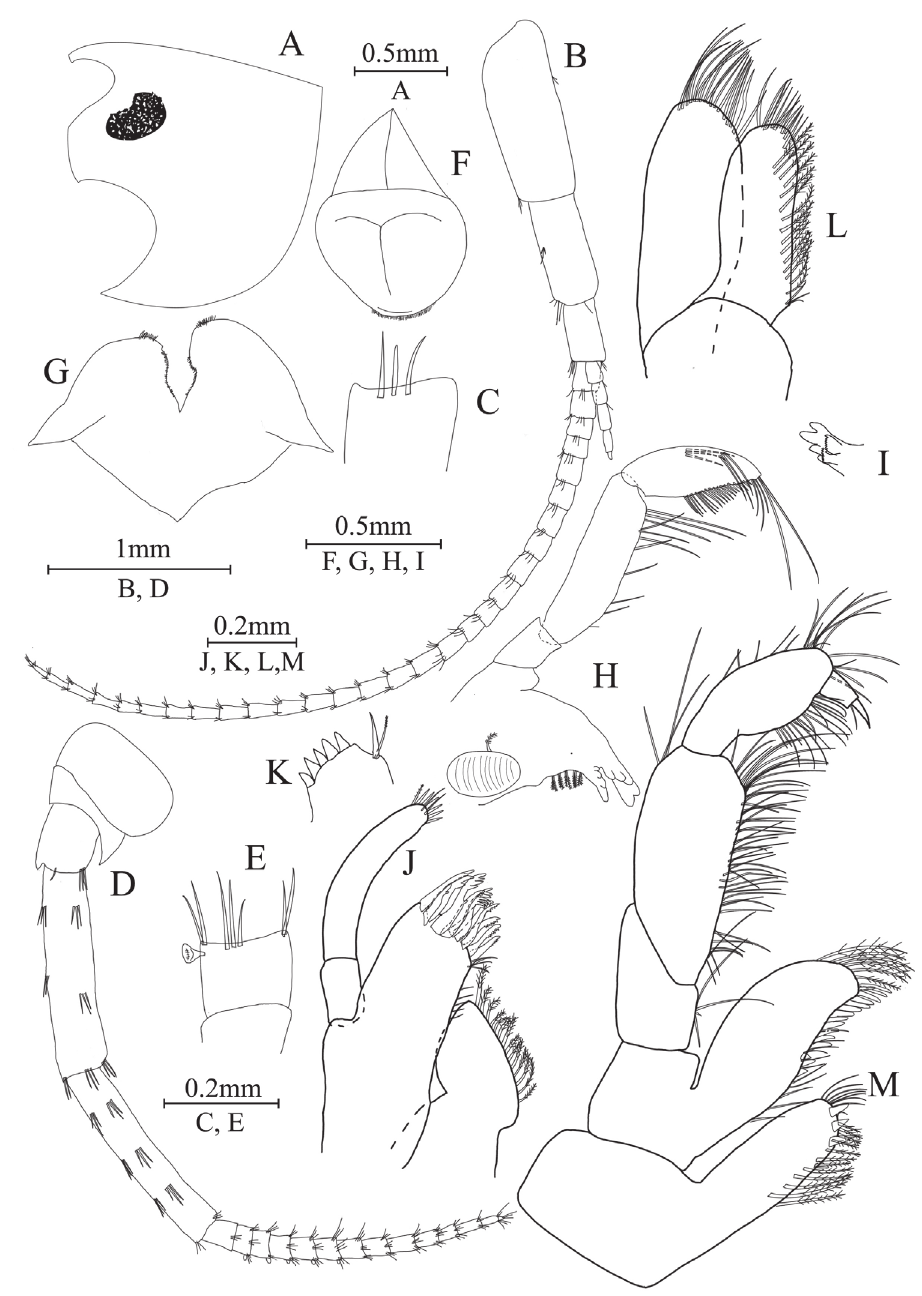
Figure 5. Gammarus zhouqiongi sp. nov., male holotype A head B antenna I C flagellar article of antenna I with aesthetasc D antenna II E calceoli of antenna II F upper lip G lower lip H left mandible I inci- sor and lacinia mobilis of right mandible J left maxilla I K distal part of palp article II of right maxilla I L maxilla II M